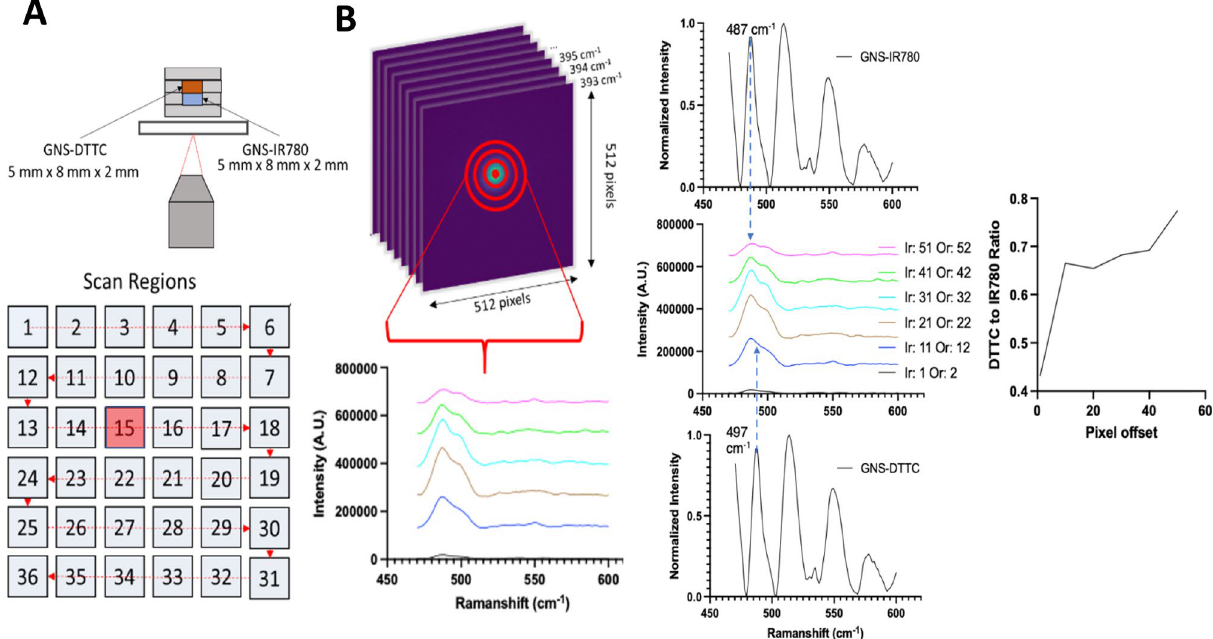
Figure 5. Detection of Raman from a dual layer sample. ( A ) Two 2 mm thick gels containing GNS-DTTC and GNS-IR780 are stacked and embedded between 2 mm thick gel layers and subsequently probed with the ORCHID system at different spectral frequencies. The resulting Raman spectra are obtained in the highlighted region containing the stacked GNS-dye sample. ( B ) As an example, the hyperspectral data cube at position 15 (highlighted in red) in the scan region is displayed with corresponding radial binnings that produce different spectra. This position represents the spatial location of the SERS-GNS gel volumes within the greater gel sample. A waterfall plot comparing the different inner and outer radial offsets is shown with the respective reference spectra of each dye above and below. As before, increasing spatial offsets resulted in the further out GNS-DTTC signal to become more prominent. Ir and Or stands for inner radius and outer radius respectively and represent the spatial offset disks.”